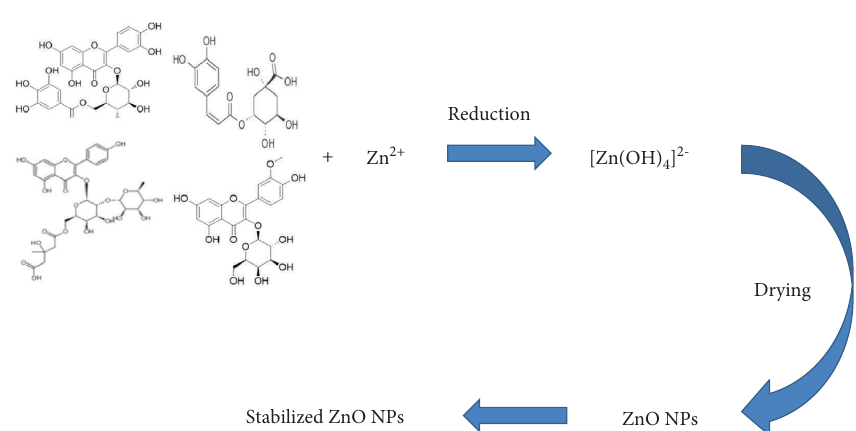
Figure 2: A proposed mechanism of synthesis of ZnO NPs utilizing the C. roseus leaf extract.